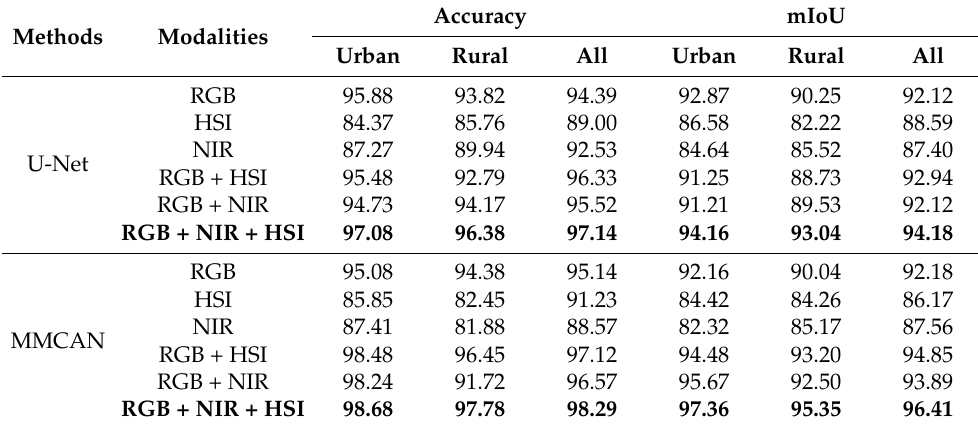
Table 3. Ablation study on different